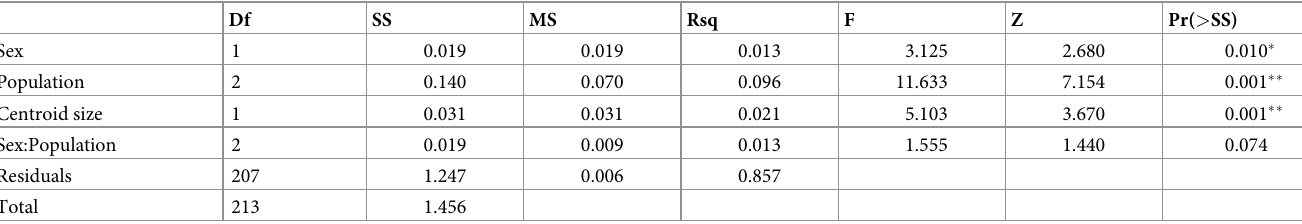
Table 2. Procrustes MANCOVA with sex, population and centroid